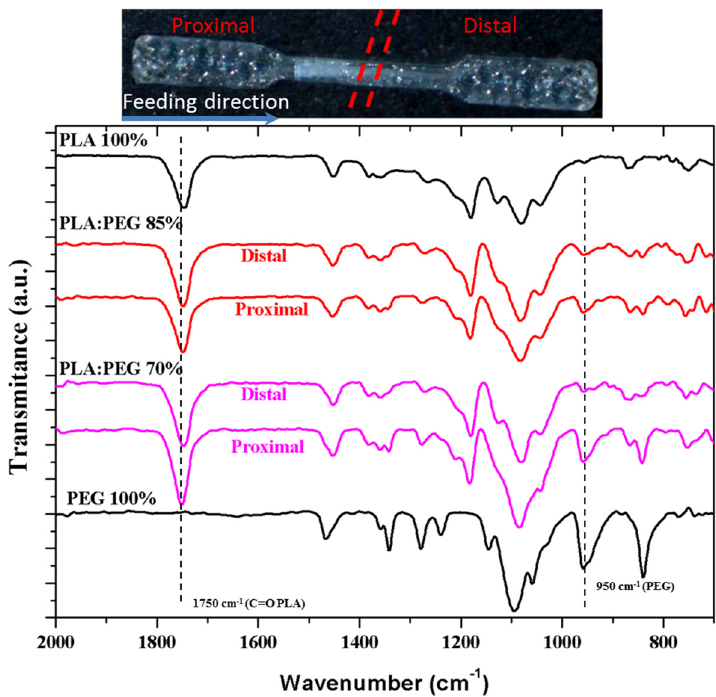
Figure 6. FTIR spectra of PLA, PEG, and selected PLA/PEG (30 and 15 wt-% of PEG) specimens. Spectra corresponding to distal and proximal parts are displayed for the blend specimens.